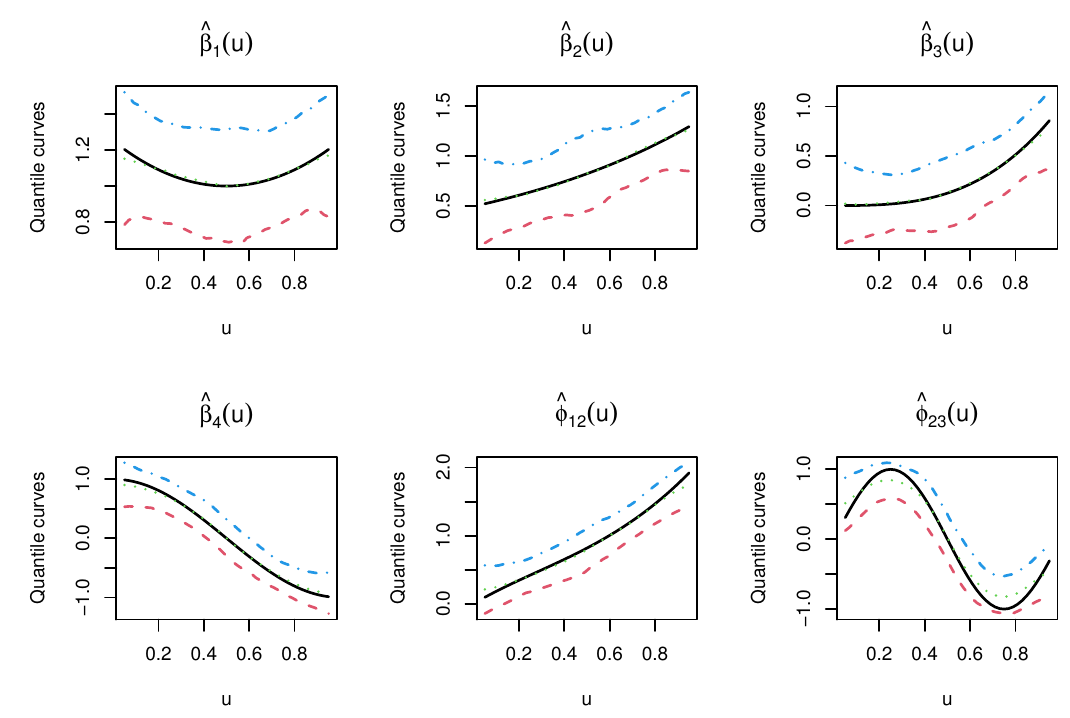
Figure 2. Estimated quantile curves of Model 2. Dash-dot lines are 0.95 quantile curves, dotted lines are 0.50 quantile curves, dashed lines are 0.05 quantile curves, and solid lines are the real function curves. The dash-dot and dashed lines indicate 90% confident bands.